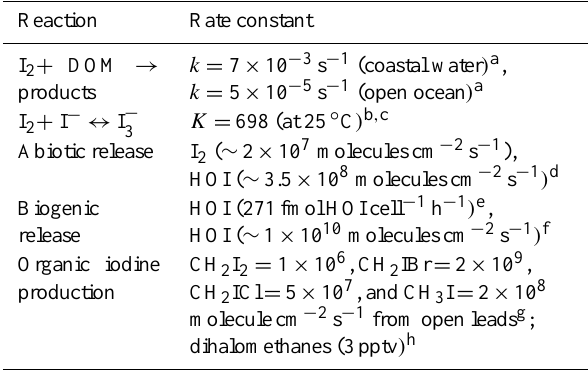
Table 2. Summary of additional iodine production and loss pro-